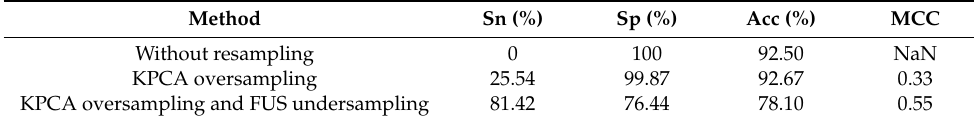
Table 1. Comparison of original imbalance dataset and balanced